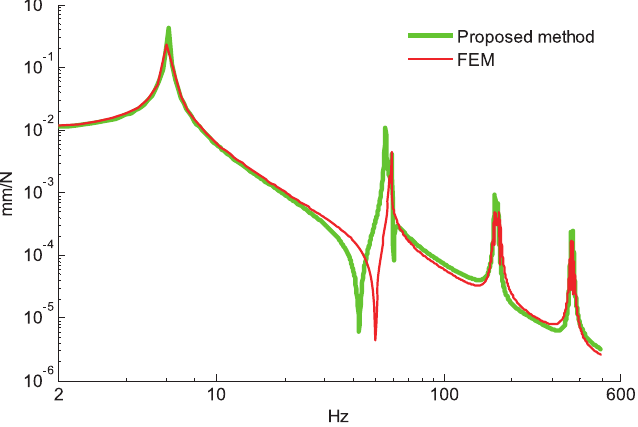
Fig. 6. Comparison of FRFs computed with different methods.